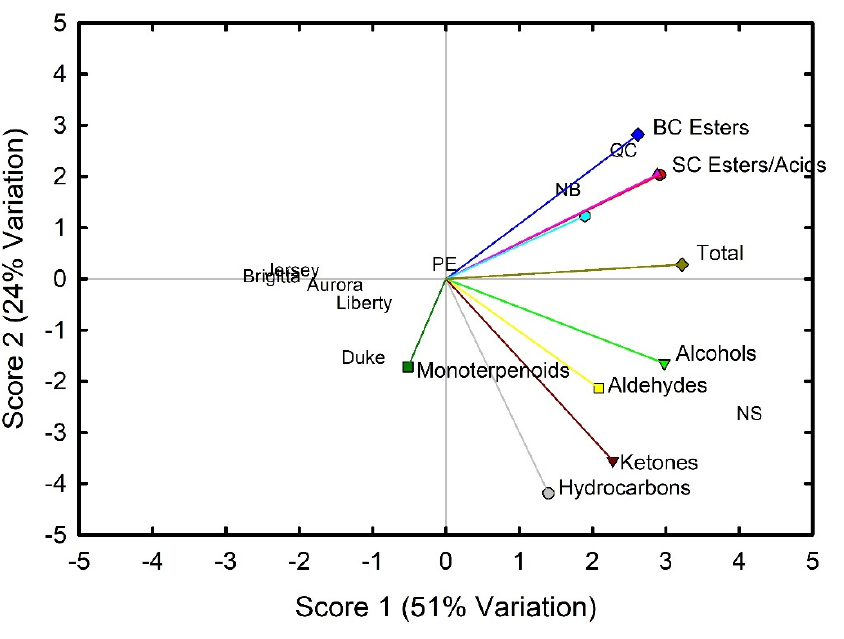
Figure 2. Principal component analysis of the volatile composition of wild lowbush blueberry fruit from four provinces and five cultivars of highbush blueberry fruit.